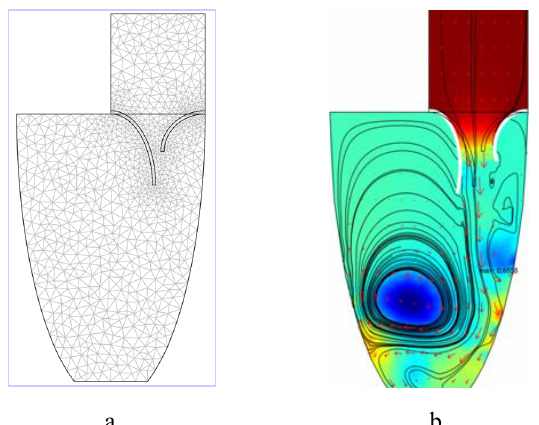
Figure 4: (a) Sample of the computational mesh and (b) large vortex behind anterior leaflet generated during